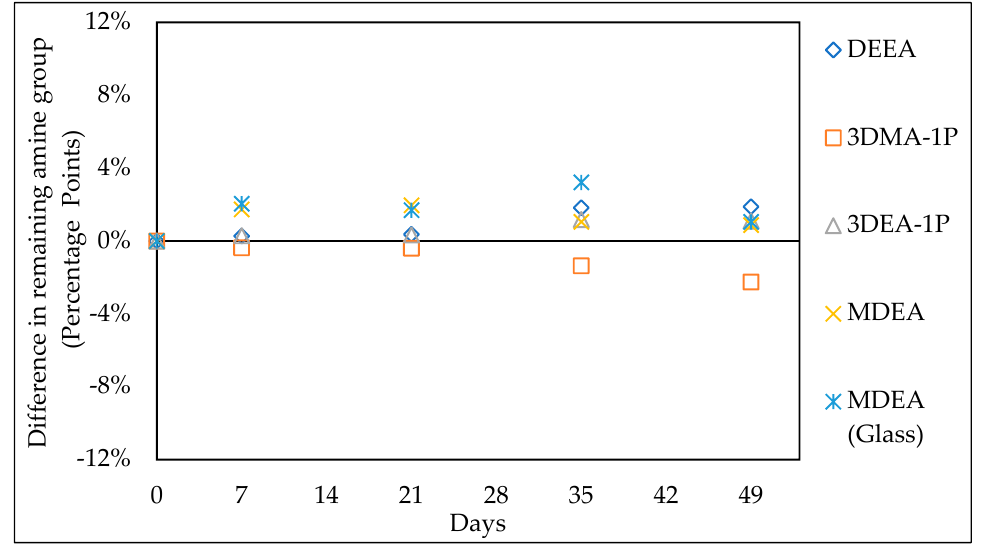
Figure 9. Difference between the remaining amine group (percentage points) of amine–MEG blends vs. amine–TEG blends; unloaded amine wt.% = 30; CO 2 loading ≈ 0.1.